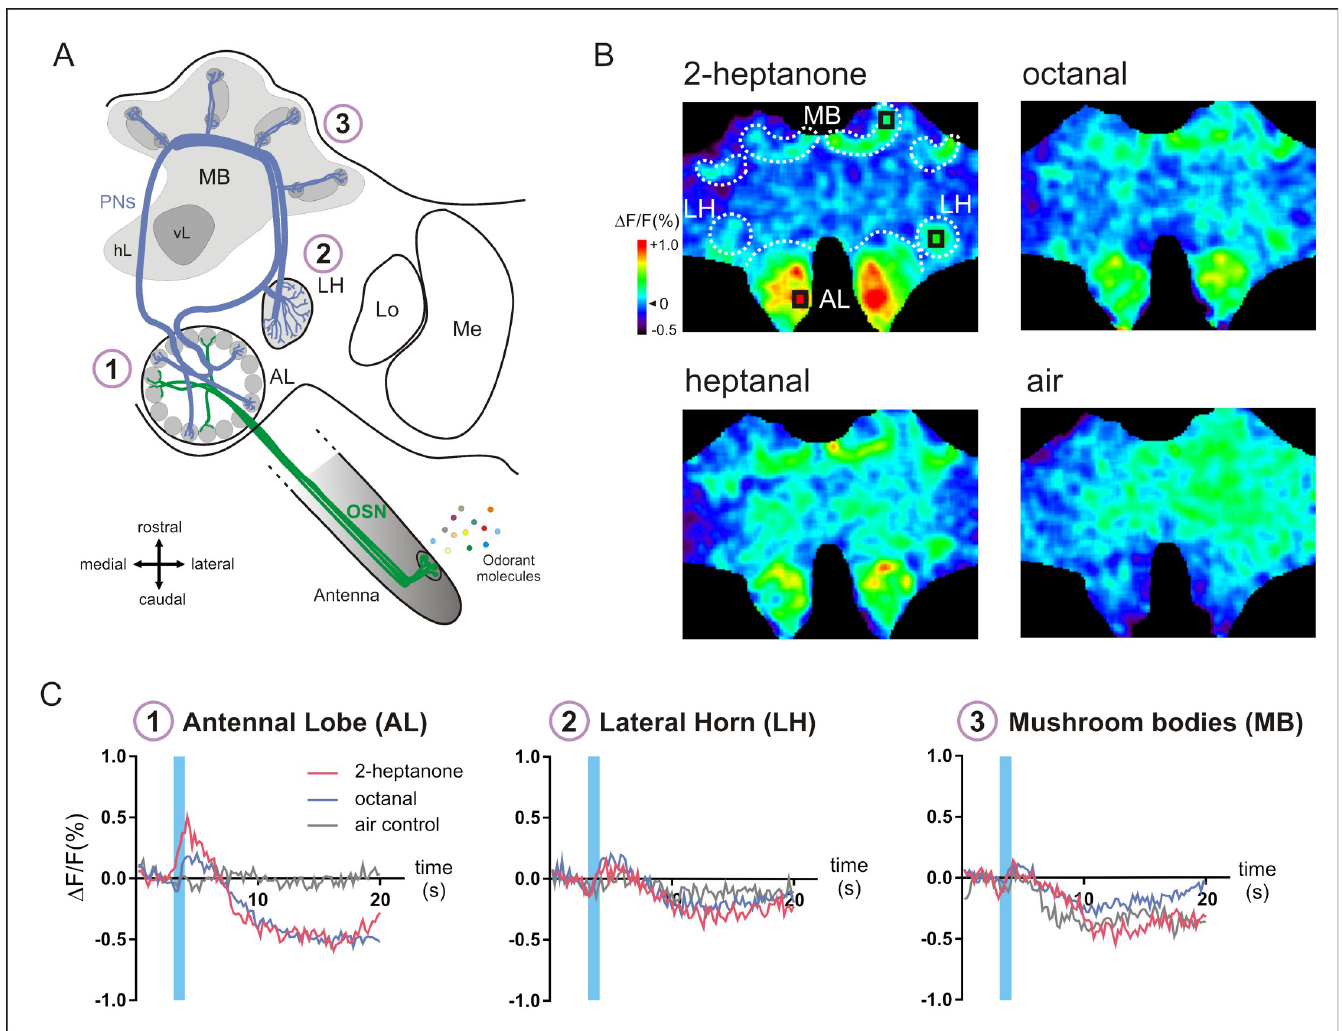
Fig 2. Neural activity in the whole brain of the honey bee. ( A ) Hymenopteran olfactory pathway (adapted from [46]). Odorant molecules are detected by OSNs on the antenna, which send olfactory information to the AL. Then, PNs convey information to higher-order centers, the MBs and the LH. Lo: lobula, Me: medulla, vL: vertical lobe, hL: horizontal lobe. ( B ) Calcium signals in the whole brain evoked by 3 different odorants (2-heptanone, octanal, heptanal) and the air control. Relative fluorescence changes ( Δ F / F [%]) are presented in a false-color code, from dark blue (minimal response) to red (maximal response). ( C ) Time course of odor-evoked responses ( Δ F / F [%], taken from the black squares shown in B) for 1 individual to the presentation of 2-heptanone (in pink), octanal (in blue), and the air control (in gray), simultaneously recorded in the AL (left), the LH (middle), and the MB (right). The calcium signals show a biphasic time course, with a fluorescence increase upon odorant presentation (blue bars) followed by a long-lasting fluorescence undershoot, in all brain regions. AL, antennal lobe; LH, lateral horn; MB, mushroom body; OSN, olfactory sensory neuron; PN, projection neuron.